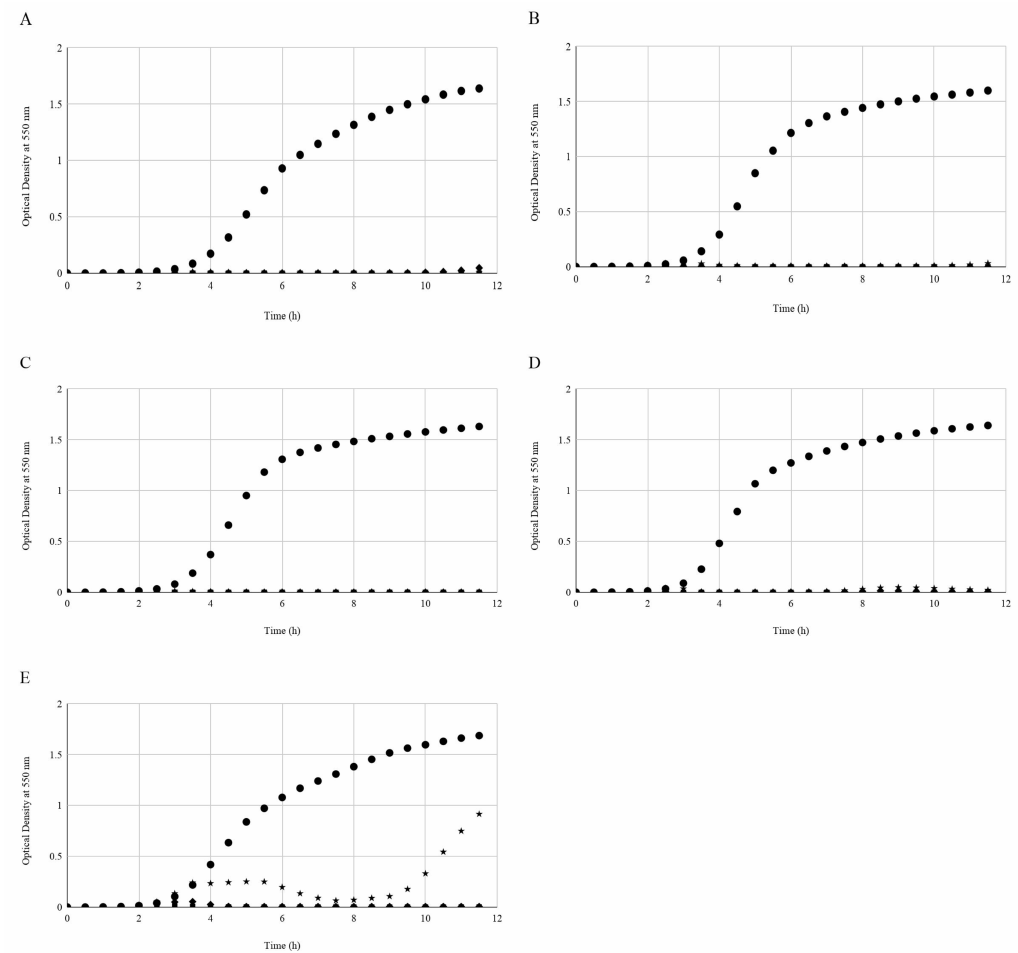
Figure 1. Growth or inhibition of Shiga-toxigenic E. coli (STEC) isolates in vitro as a function of phage dilution. Symbols depict mean optical density at 550 nm (OD 550 ) from triplicate identical replicates ( N = 3) for STEC isolates grown in the absence (Control; ), phages diluted 10 − 1 from commercial phage intervention ( (cid:78) ), phages diluted 10 − 2 ( (cid:110) ) phages diluted 10 − 3 ( (cid:169) ), or phages diluted 10 − 4 ( (cid:63) ). Panels relate the growth of E. coli O157:H7 ( A ), O45:H2 ( B ), O103:H2 ( C ), O111:H- ( D ), or O121:H19 ( E